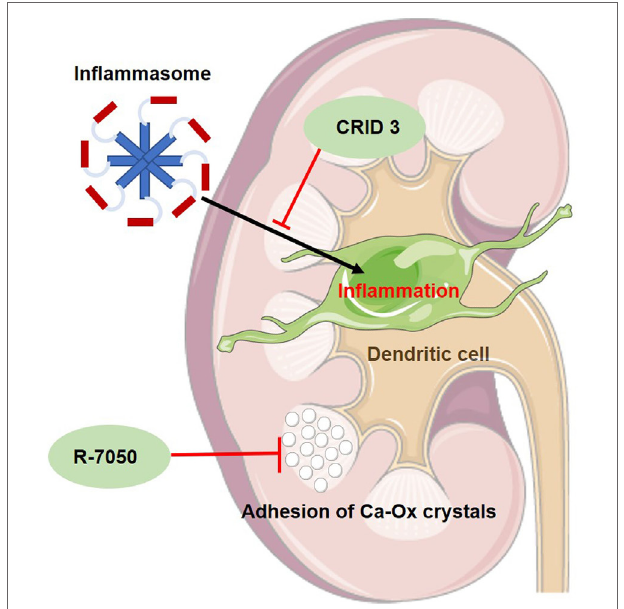
FiGURe 1 | Schematic figure of the mode of action of two new experimental drugs for primary hyperoxaluria I. CRID 3 inhibits inflammasome-mediated inflammation in dendritic cells of the kidney and thus reducing kidney fibrosis. R-7050 is a TNF-receptor inhibitor, delaying the progression of nephrocalcinosis since it seems to prevent adhesion of calcium oxalate (Ca-Ox) crystals to renal